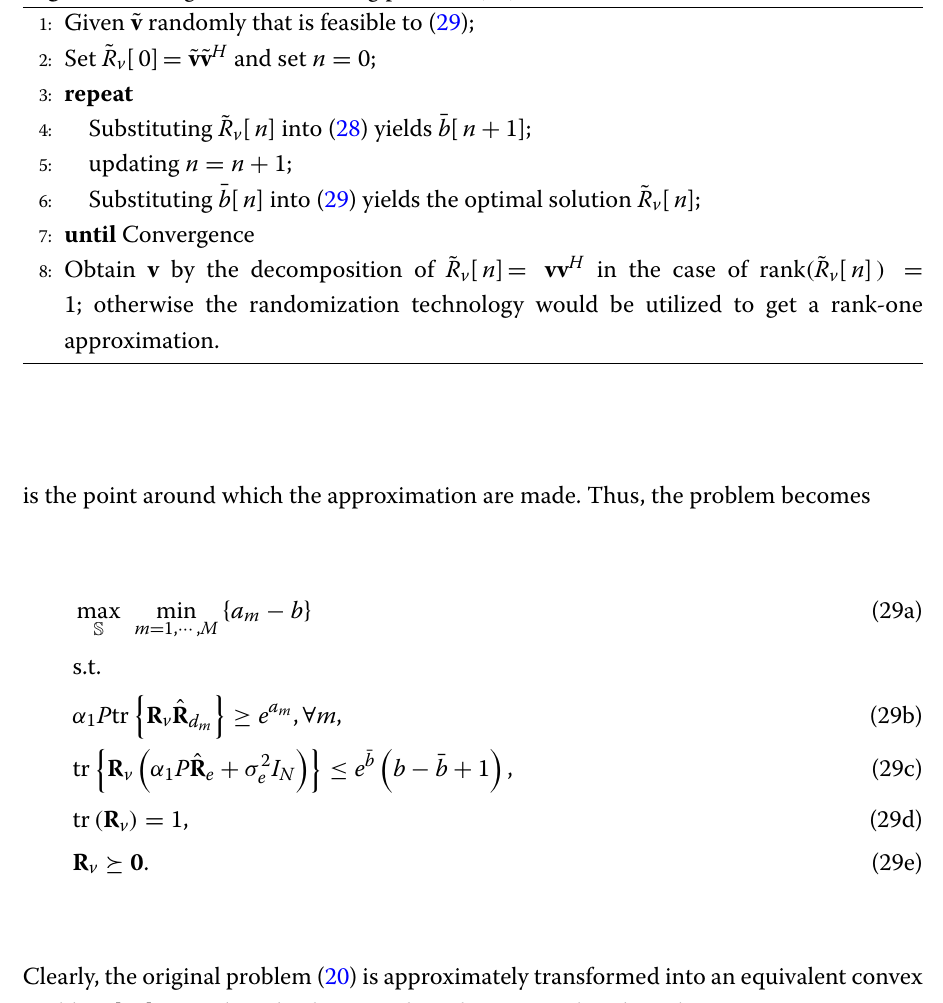
Algorithm 1 Algorithm for solving problem